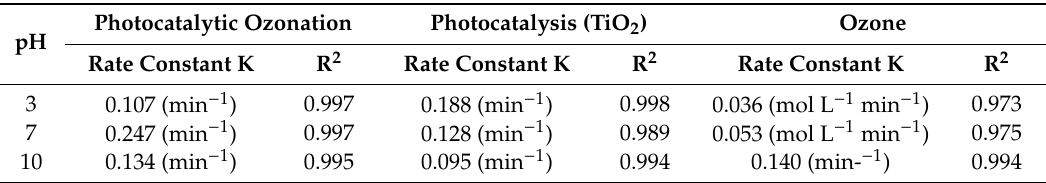
Table 1. Imazapyr degradation rate constant for photocatalytic ozonation, photocatalysis (TiO 2 ) and ozone. Photocatalytic pH